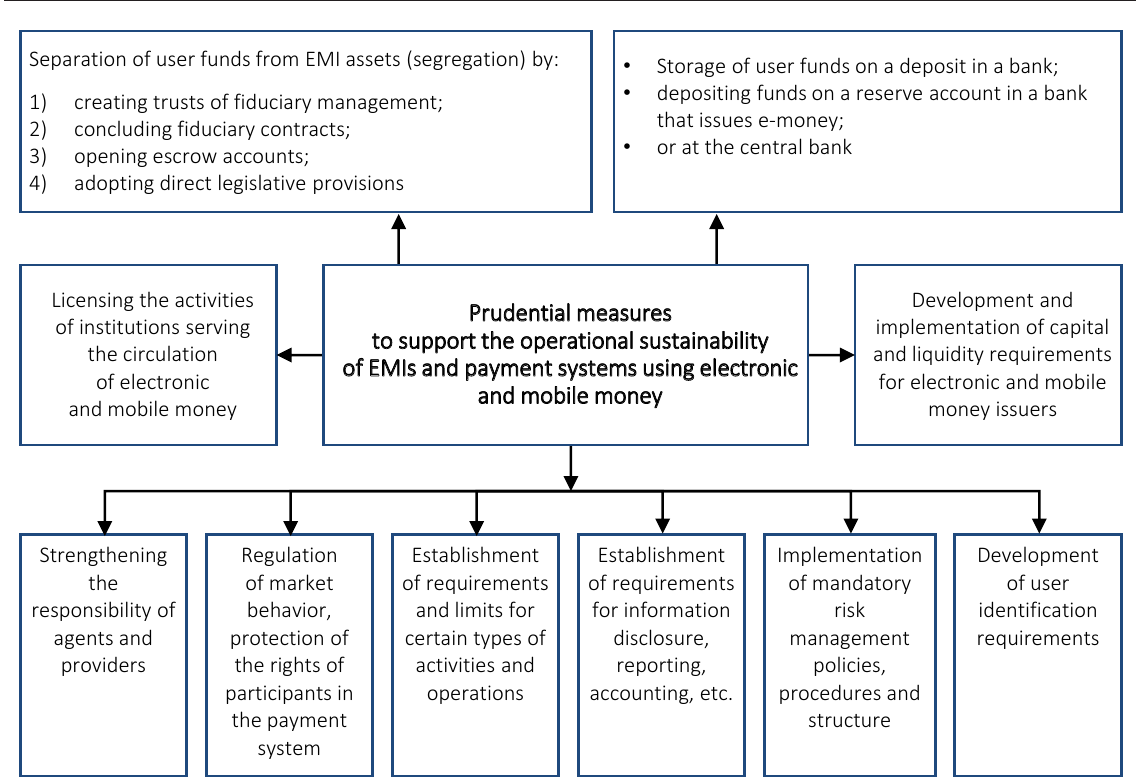
Figure 4. A system of regulatory and prudential measures aimed at supporting the operational sustainability of EMIs and payment systems under their